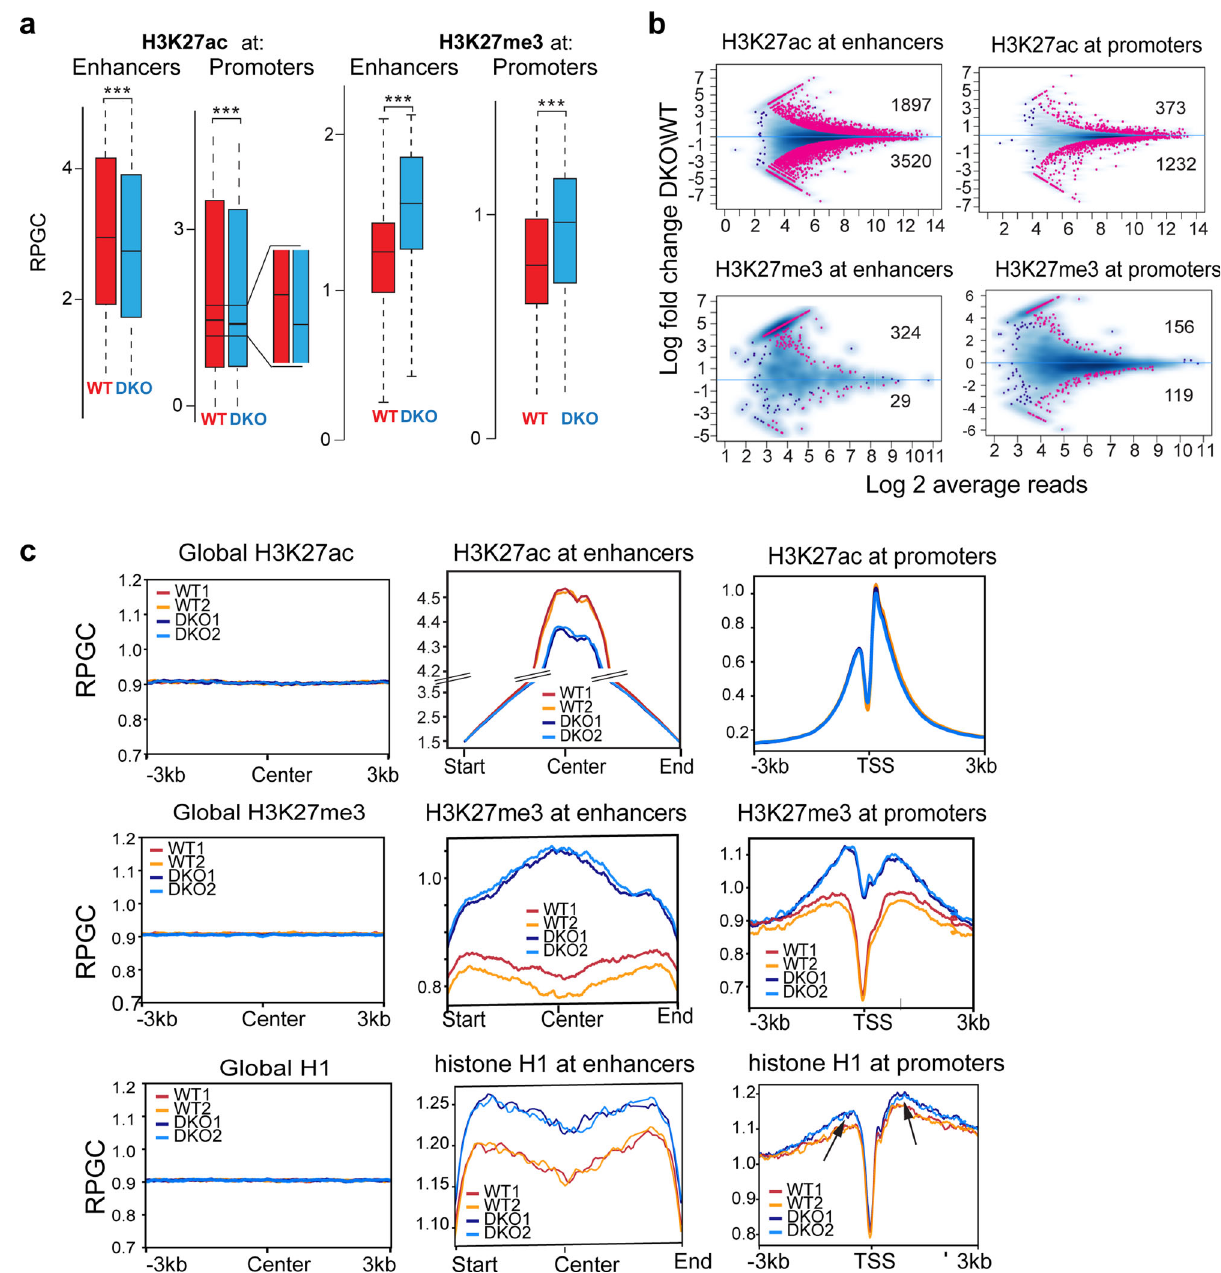
Fig. 3 Loss of HMGN alters H3K27modi fi cations and H1 occupancy at chromatin regulatory sites of MEFs. a Box plot showing decreased H3K27ac but increased H3K27me3 levels at enhancers and promoters of DKO mice. b MA plots showing differences between WT and DKO cells in H3K27ac or H3K27me3 levels at enhancers and promoters. Statistically signi fi cant differences (FDR < 0.05) are shown in red. Blue dots and blue density cloud represents all points corresponding to the nonchanging regions. c Aggregate plots showing the distribution of the average H3K27ac, H3K27me3 and histone H1 levels in WT and DKO MEFs. Left panels: throughout the genome (regulatory sites subtracted). “ Center ” indicates a location of the middle point of each 6kbp bin. Center panels: at enhancers. In these panels all cellular enhancers were aligned at their center. RPGC: reads per genomic coverage. Right panels: at promoters, Arrows point to promoter regions where H1 occupancy differs between WT and DKO cells. All ChIP analyses from two biological replicates. Regulatory sites identi fi cation is based on UCSC genome annotation HMGN does not affect the DNA binding sequence speci fi city of line), while the lost CEBPB sites are not surrounded by known CEBPB. For both lost and retained sites, the CEBPB ChIP seq transcription factor binding motifs (Fig. 5f bottom line). In peaks align narrowly on the center of the CEBPB binding motif, addition, the H3K27ac levels at retained sites are higher than at (Fig. 5f, top two lines); however, a search for TF DNA-binding the lost sites (Fig. 5g). In WT MEFs, 64% of CEBPB binding sites sequence motifs uniquely present only in retained, or only in lost localized to chromatin regions showing H3K27ac reads; 86% of CEBPB sites show differences between these sites. The retained these also showed HMGN1 and HMGN2 occupancy. At CEBPB sites are fl anked by DNA binding motifs for additional nonacetylated sites, the co-occupancy of CEBPB with HMGN transcription factors such as FOSB, JUN, and ATF3 (Fig. 5f, third was only 39% (Fig. 5h). Representative IGV screenshots